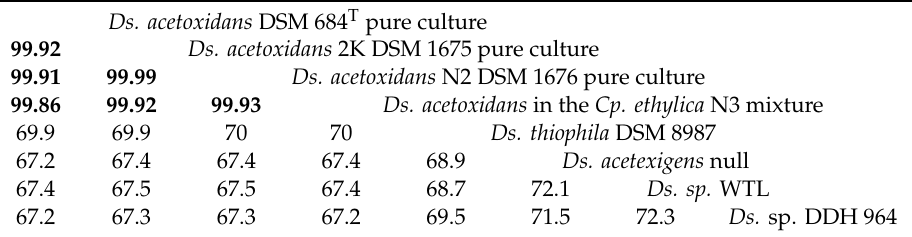
Table 3. Percentage average nucleotide identity of some Desulfuromonas sulfur-reducing bacteria.